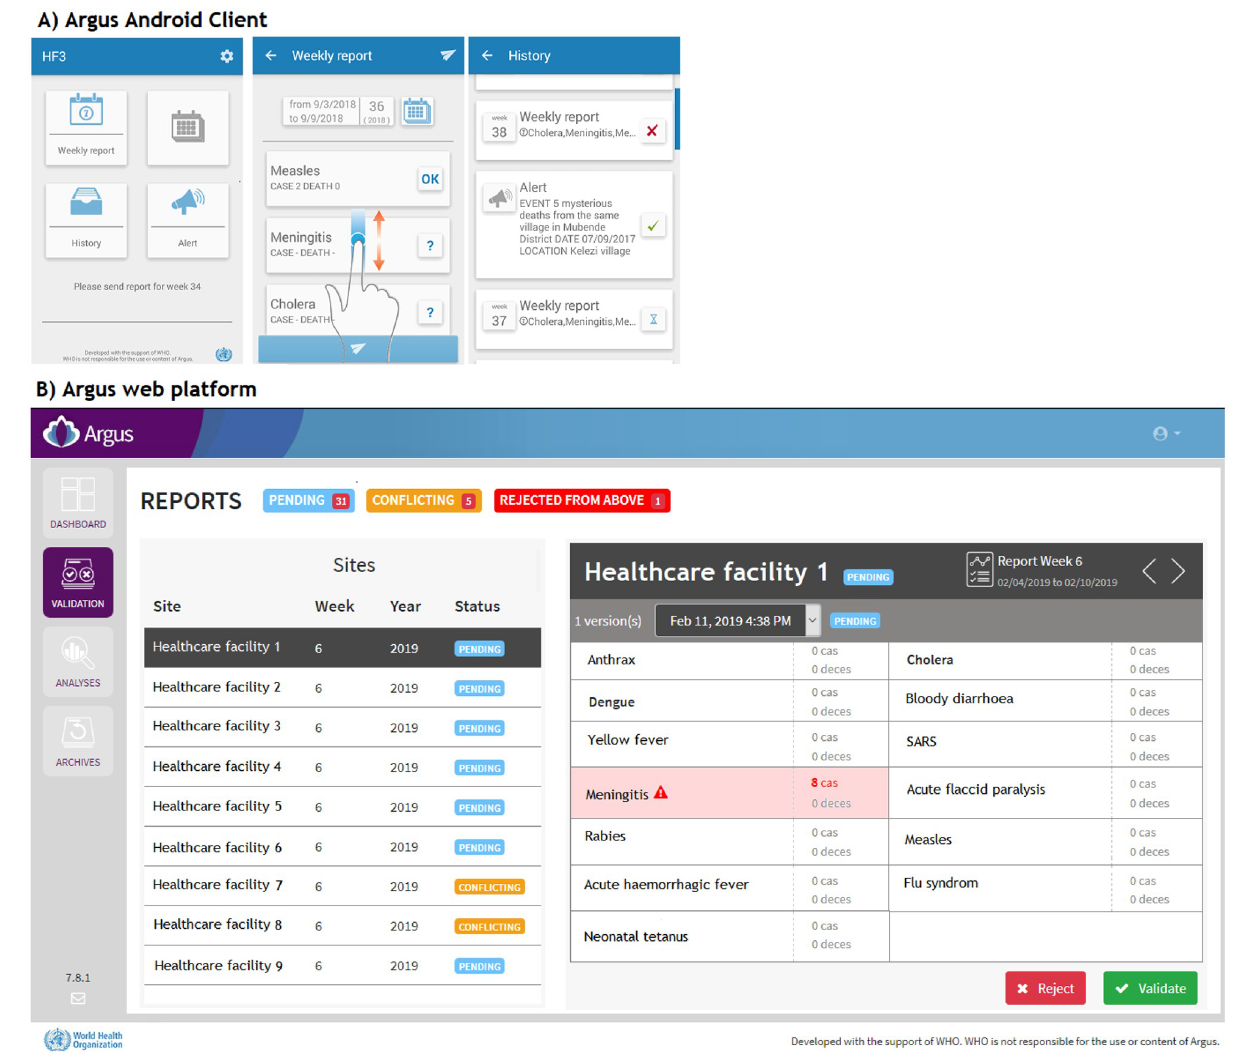
Fig 1. Argus IT solution for public health